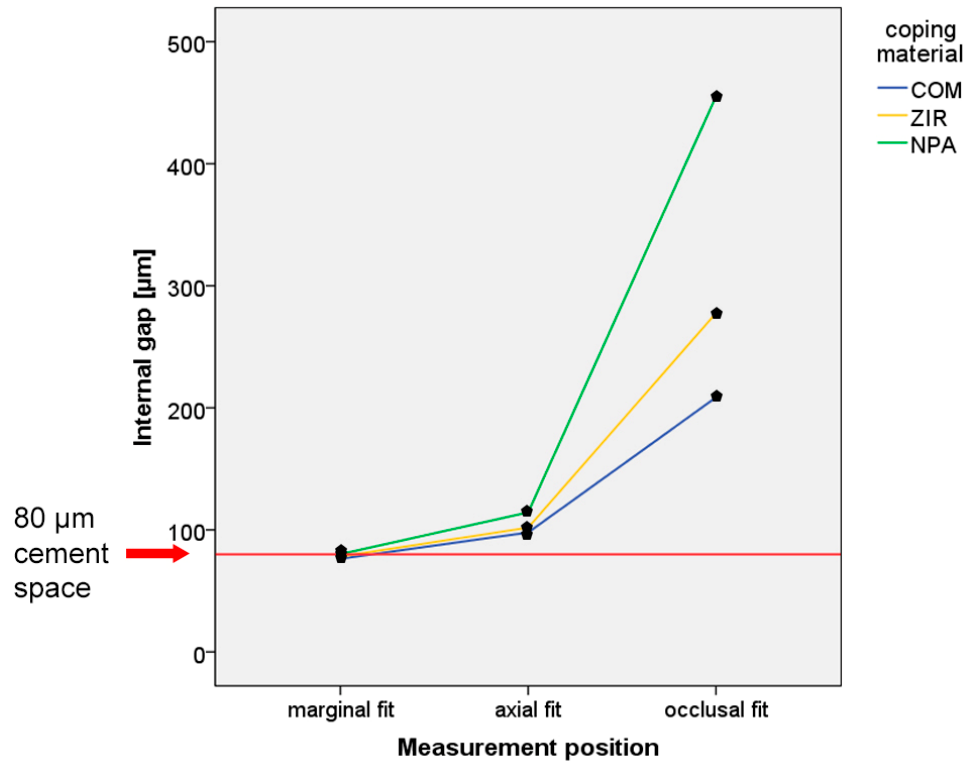
Figure 5. Line chart of interaction between the coping material and measurement position. Table 4. Results of internal fit measurement (pooled data for the three evaluation methods, COM = resin composite, ZIR = zirconium dioxide and NPA = non-precious alloy).